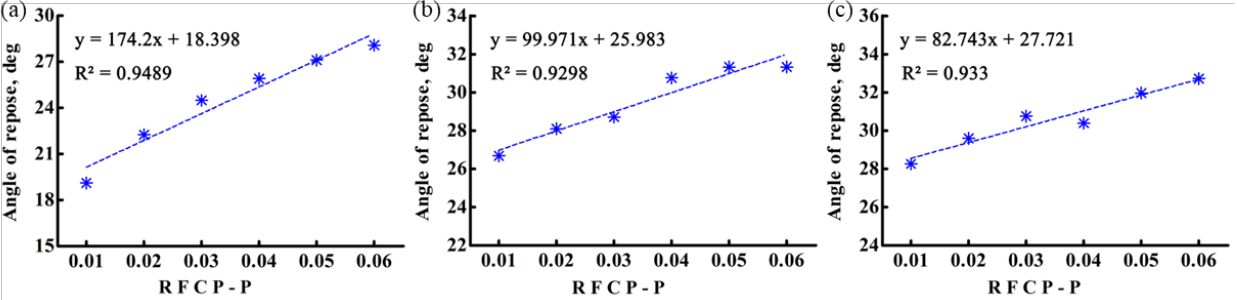
Figure 14. Test and simulation diagram of the repose angle of soybean seed particles mixed with organic glass spheres.